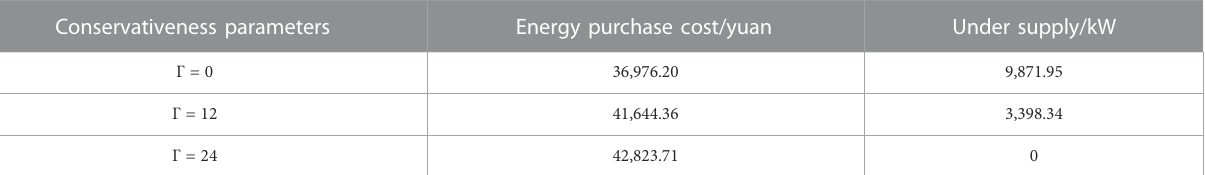
TABLE 3 Simulation results of scenario 3. Conservativeness